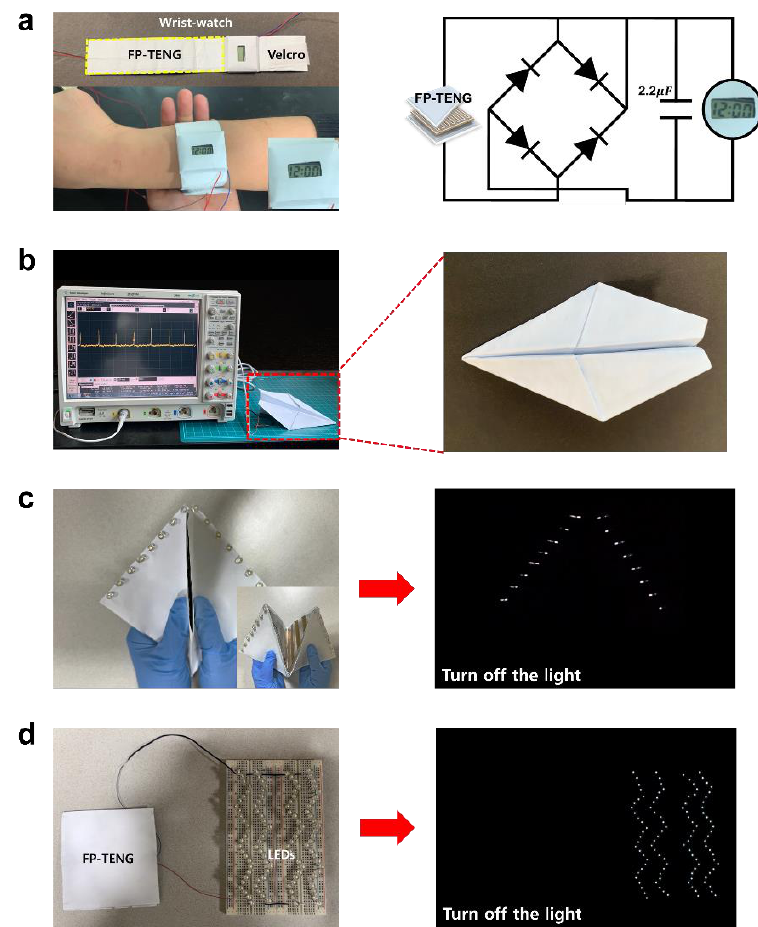
Figure 5. ( a ) Demonstration of the FP-TENG continuously driving a wristwatch, and schematic of a full-wave rectifier circuit. ( b ) Output voltage of FP-TENG folding under pushing motion. ( c ) LEDs powered by the FP-TENG under folding and unfolding motions. ( d ) Lighting of 96 LEDs via hand tapping and visibility in a dark environment.